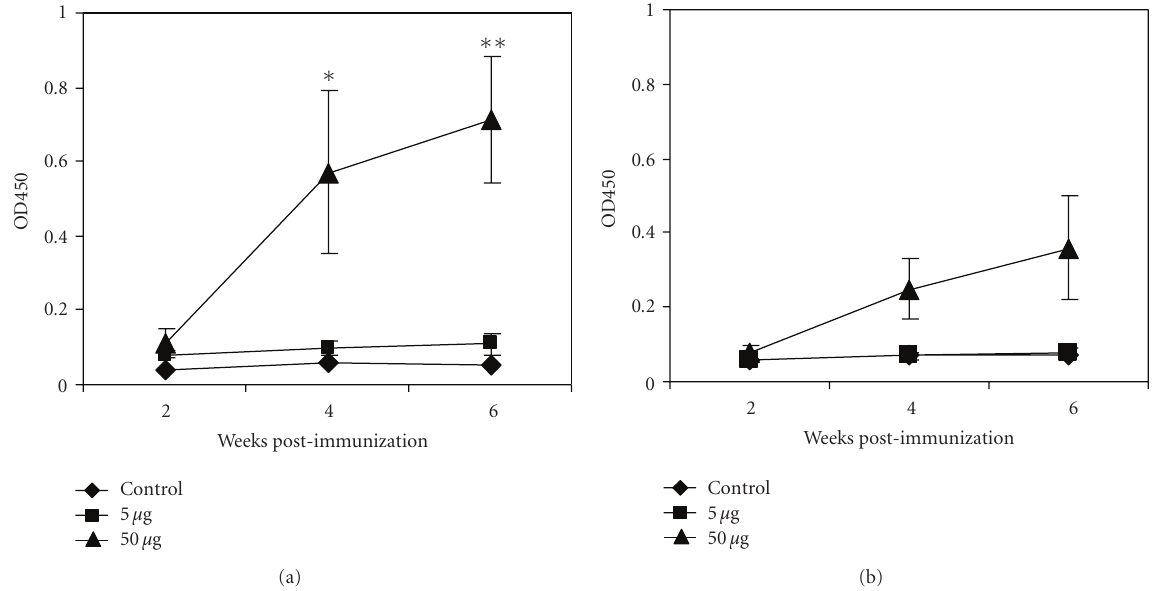
Figure 6: Immunization with a high dose (50 μ g/mouse) of TcoMSP-D resulting in an increased antigen specific IgG1 antibody response. Groups of 5 BALB/c mice were immunized subcutaneously with TiterMax alone (Control), 5 μ g, or 50 μ g of antigen TcoMSP-D (amino- terminal domain) in TiterMax at 4 di ff erent sites (25 μ L/site). Serum was collected at weeks 2, 4, and 6 postimmunization. Sera IgG1 (a) and IgG2a (b) specific for TcoMSP-D were determined by ELISA. The 50 μ g group showed a significantly higher IgG1 antibody titer than the control group at week 4 and week 6 postimmunization. ∗ P ≤ . 05; ∗∗ P ≤ .